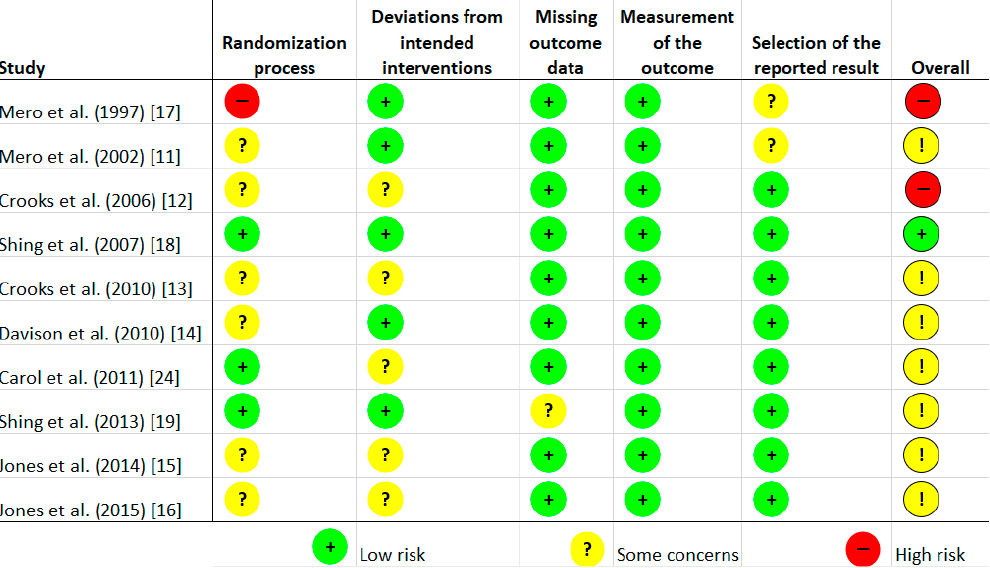
Figure 1. Risk of bias of included studies.